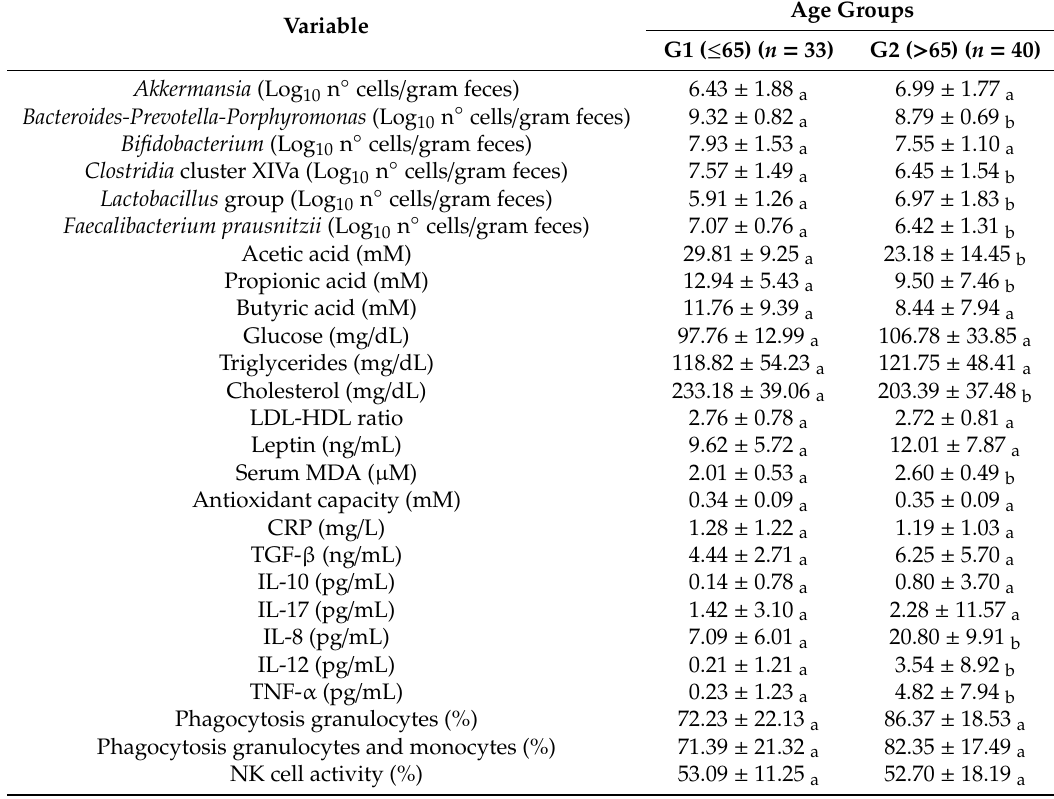
Table 2. Microbial levels, short chain fatty acid (SCFA) concentration and blood biomarkers according to age groups.